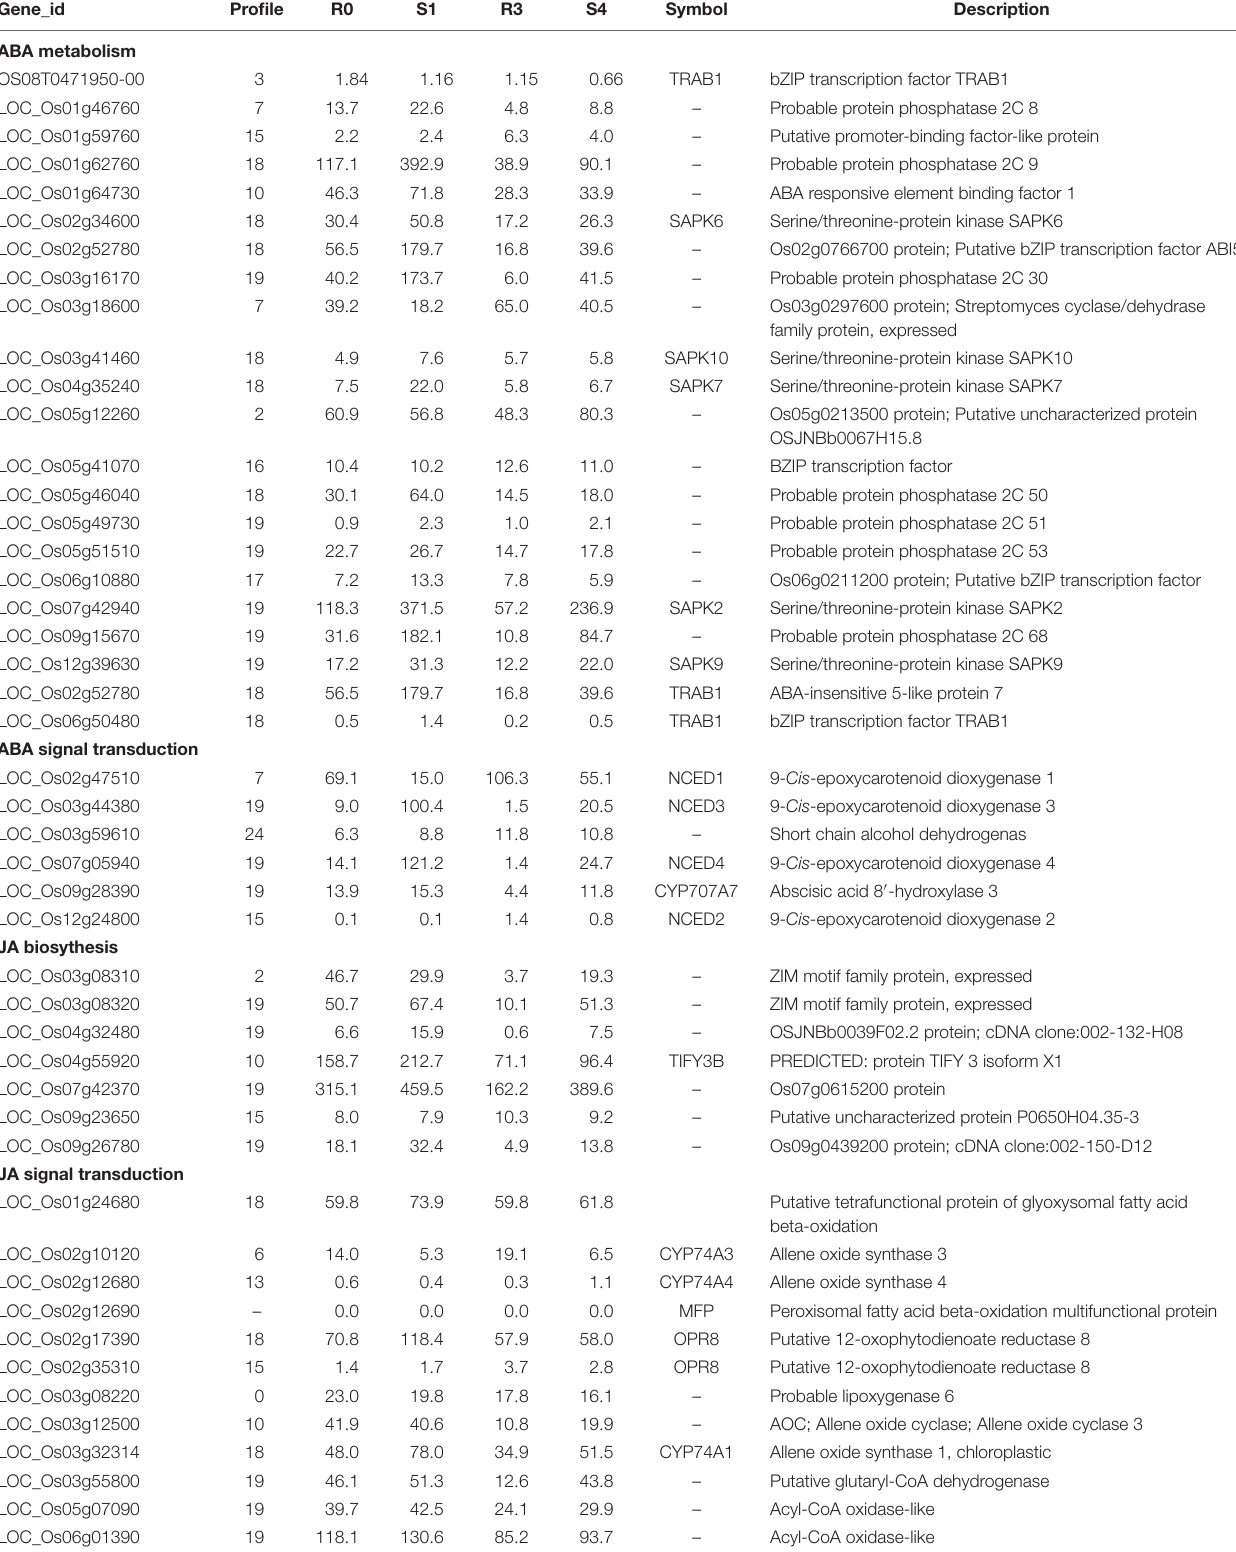
TABLE 1 | List of memory transcripts involved in ABA and JA metabolism and